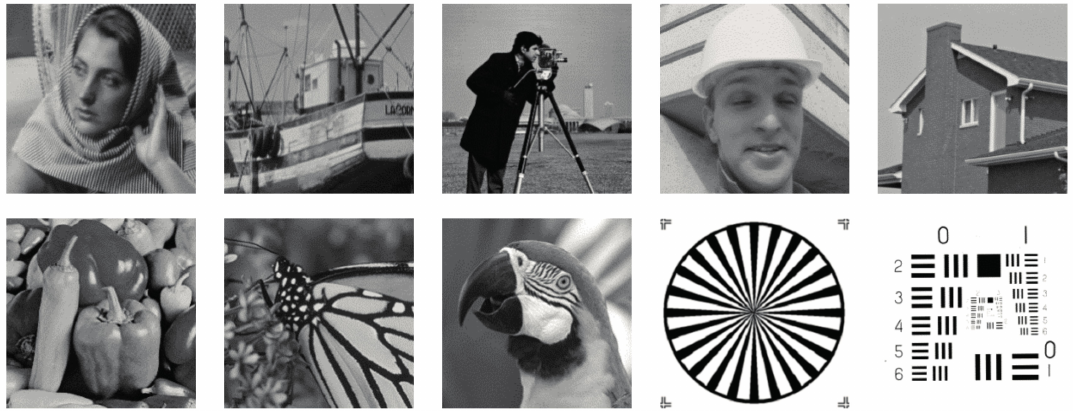
Figure 1. Standard test images used in experiments. From left to right, first row: Barbara, Boats, Cameraman, Foreman, House; second row: Peppers, Monarch, Parrots, Testpat1, Testpat2.